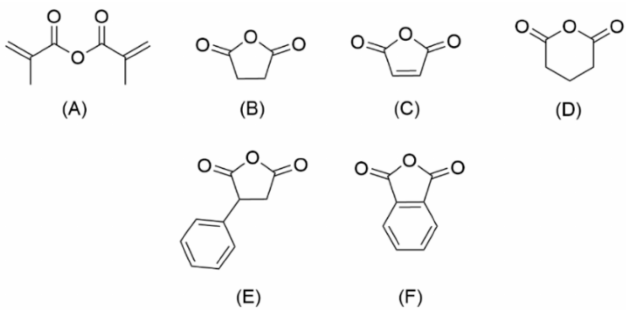
Figure 4. Most common anhydrides used in CS derivatization: ( A ) methacrylic anhydride, ( B ) suc- cinic anhydride, ( C ) maleic anhydride, ( D ) glutaric anhydride, ( E ) phenylsuccinic anhydride and ( F ) phthalic